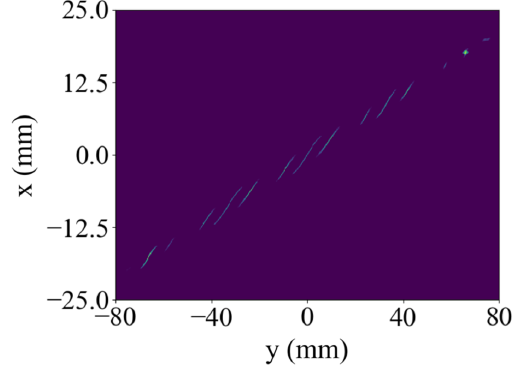
FIG. 11. x - y beam image on the screen at the end of a projection beam line for a longitudinal slice measurement. The image was generated with a start-to-end simulation.